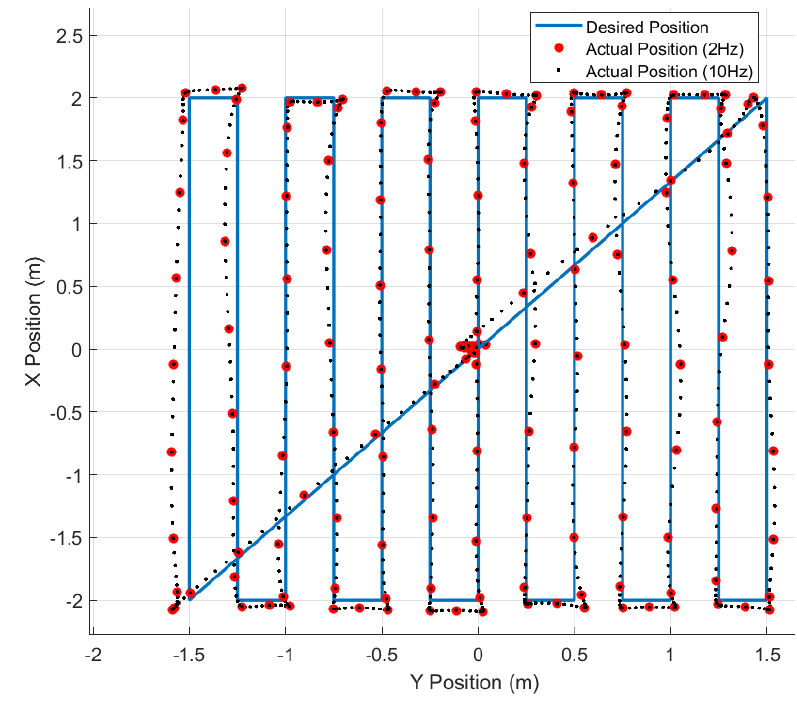
Figure 4. Single-altitude lawnmower trajectory used in all trajectories in this